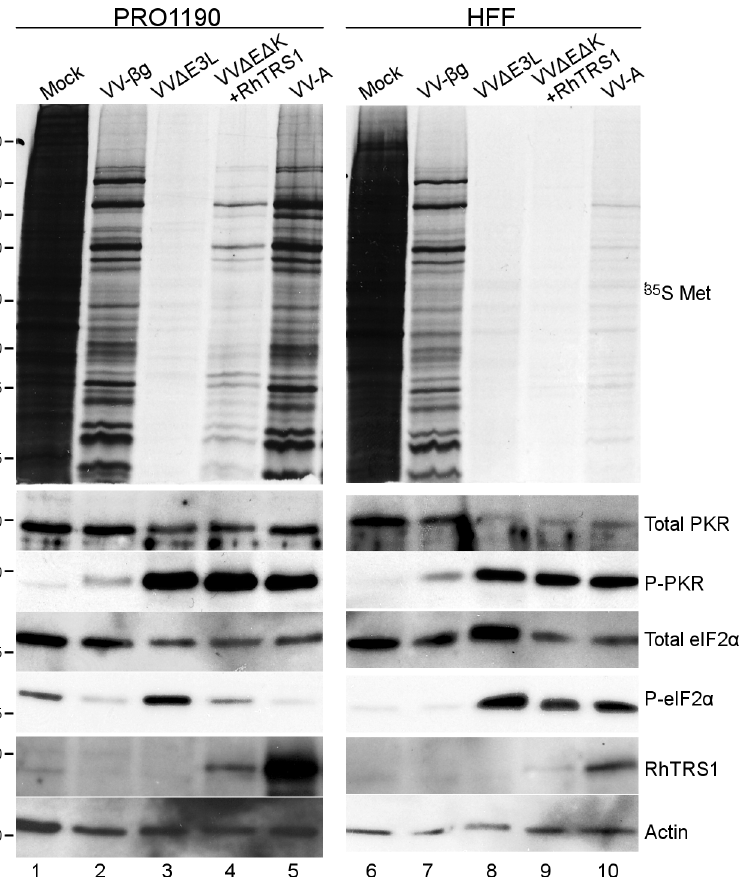
Figure 6. Effects of RhTRS1 overexpression on the PKR pathway in PRO1190 or HFF. PRO1190 (left) or HFF (right) were infected with the indicated viruses (MOI=3) for 24 hpi. Proteins were labeled with 35 S-methionine for 1 h and cell lysates were analyzed by autoradiography (top panel) or immunoblotting with the indicated antibodies (bottom panels).